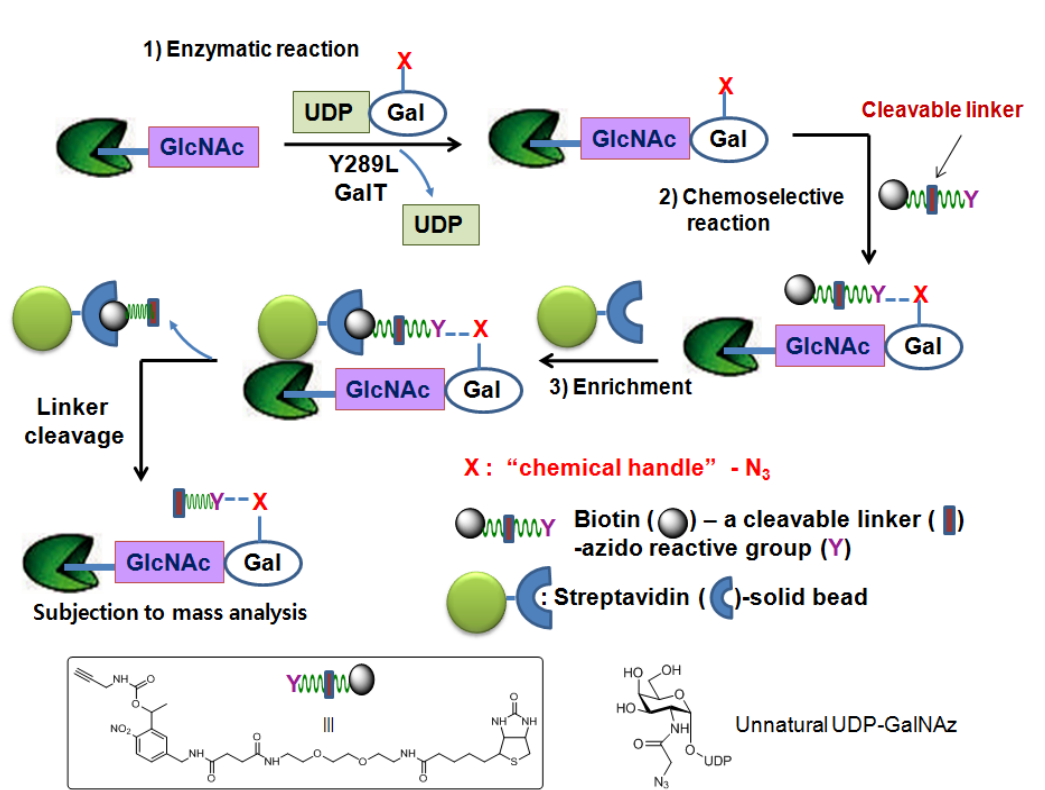
Figure 5. Chemoenzymatic tagging of O -GlcNAc-based enrichment strategies with the photocleavable